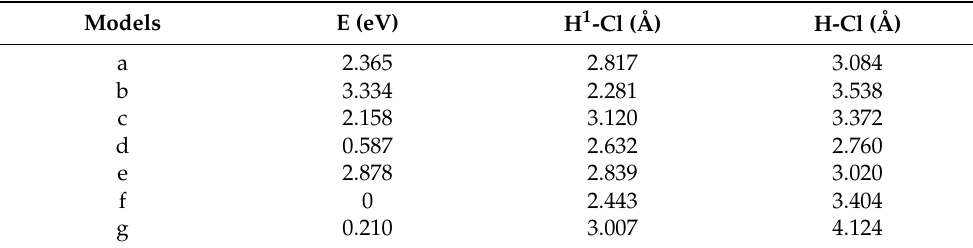
Figure 2. Energy differences across seven water monomer conformations. Structure f is the base- line and has the lowest system electrostatic potential.